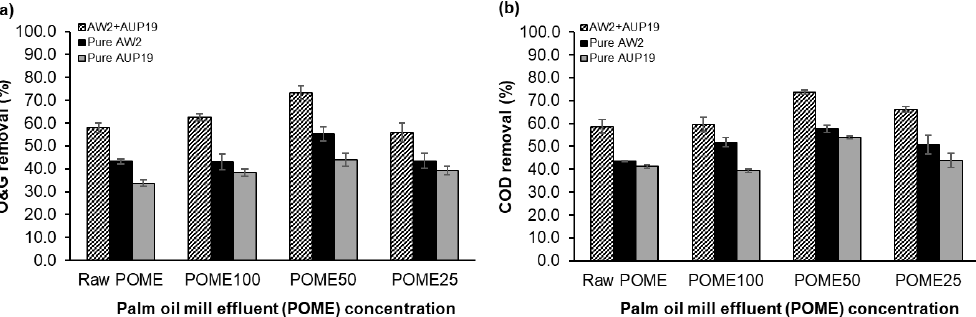
Figure 7. Bioremediation of POME under sterilized conditions in various POME concentrations, i.e., raw POME, POME100, POME50, and POME25. The parameters of O&G removal ( a ) and COD removal ( b ) were measured after inoculation with CBLs obtained from the oily waste medium at room temperature (30 ± 2 °C), 150 rpm, for 72 h.